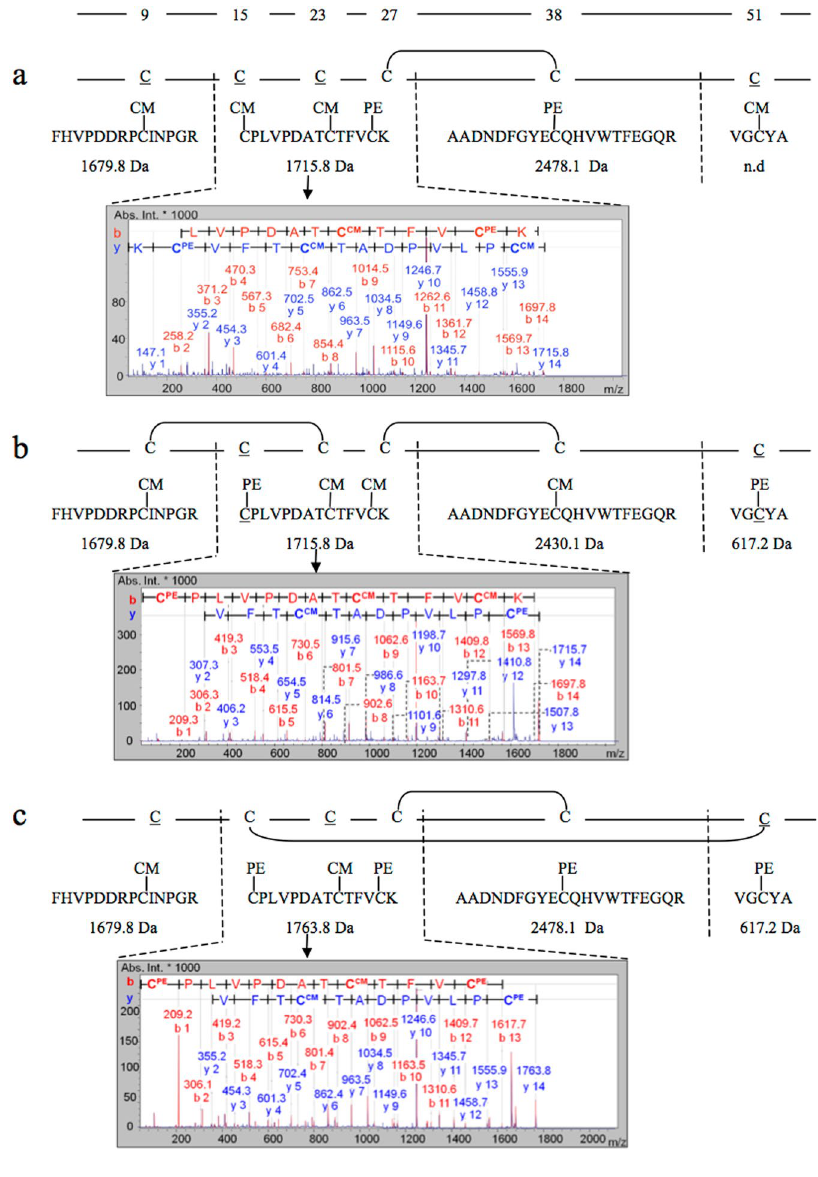
Figure 5. Disulfide-pairing determination of the major oxidative folding intermediates of NvCI. CM stands for carboximethyl cysteine (alkylated with IAA) and PE stands for pyridylethyl cysteine (alkylated with VP). The cysteine positions are indicated above the graph. ( a ) Characterization of fraction I: The purified fraction I was derivatized with IAA, reduced with DTT and further derivatized with VP prior trypsin digestion. The molecular masses determined by MALDI-TOF-MS for the derivatized tryptic peptides are shown. The 1715.8 Da derivatized peptide was sequenced by MALDI-TOF-MS 2 and the spectrum characterized by β and γ ion series with the assigned sequence is shown. ( b ) Fraction IIb characterization: The purified IIab fraction was derivatized with VP and purified by RP-HPLC (see Fig. 5c, II b-PE). Then it was reduced with DTT, derivatized with IAA and subjected to trypsin digestion and MALDI-TOF analysis. The 1715.8 Da fragment was sequenced by MALDI-TOF-MS 2 and the spectrum with the assigned sequence is shown. ( c ) Fraction IIa characterization: The purified IIab fraction was derivatized with IAA and purified by RP-HPLC (see Fig. 5, II a-CM). Then it was reduced with DTT, derivatized with VP and subjected to trypsin digestion and MALDI-TOF analysis. The 1763.8 Da fragment was sequenced by MALDI-TOF-MS 2 and the assigned sequence is